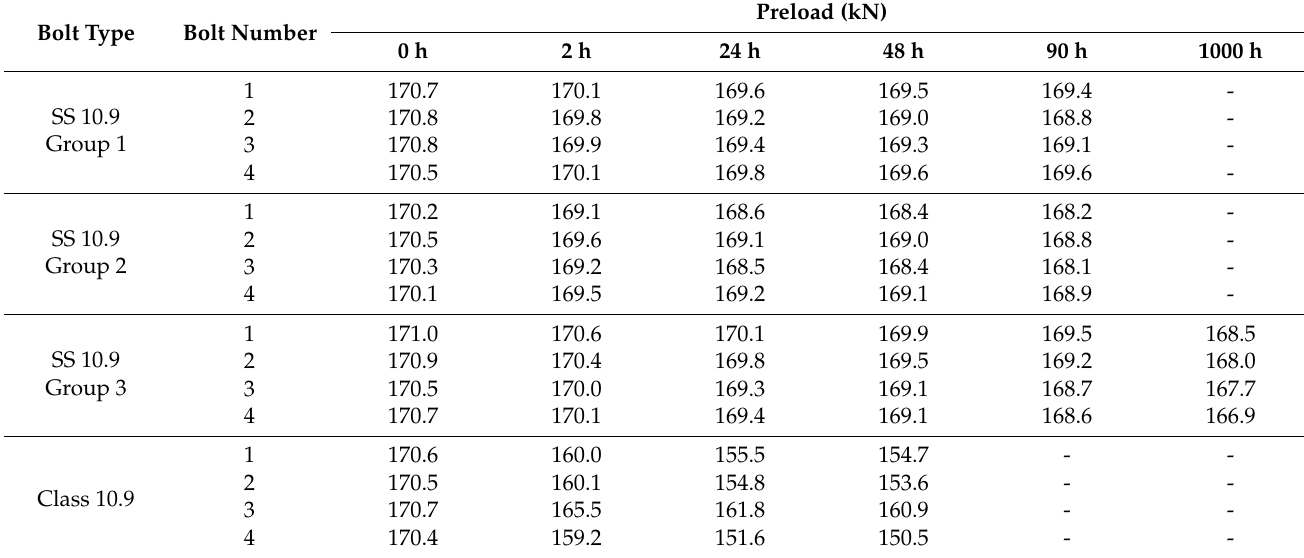
Table 3. Results of preload